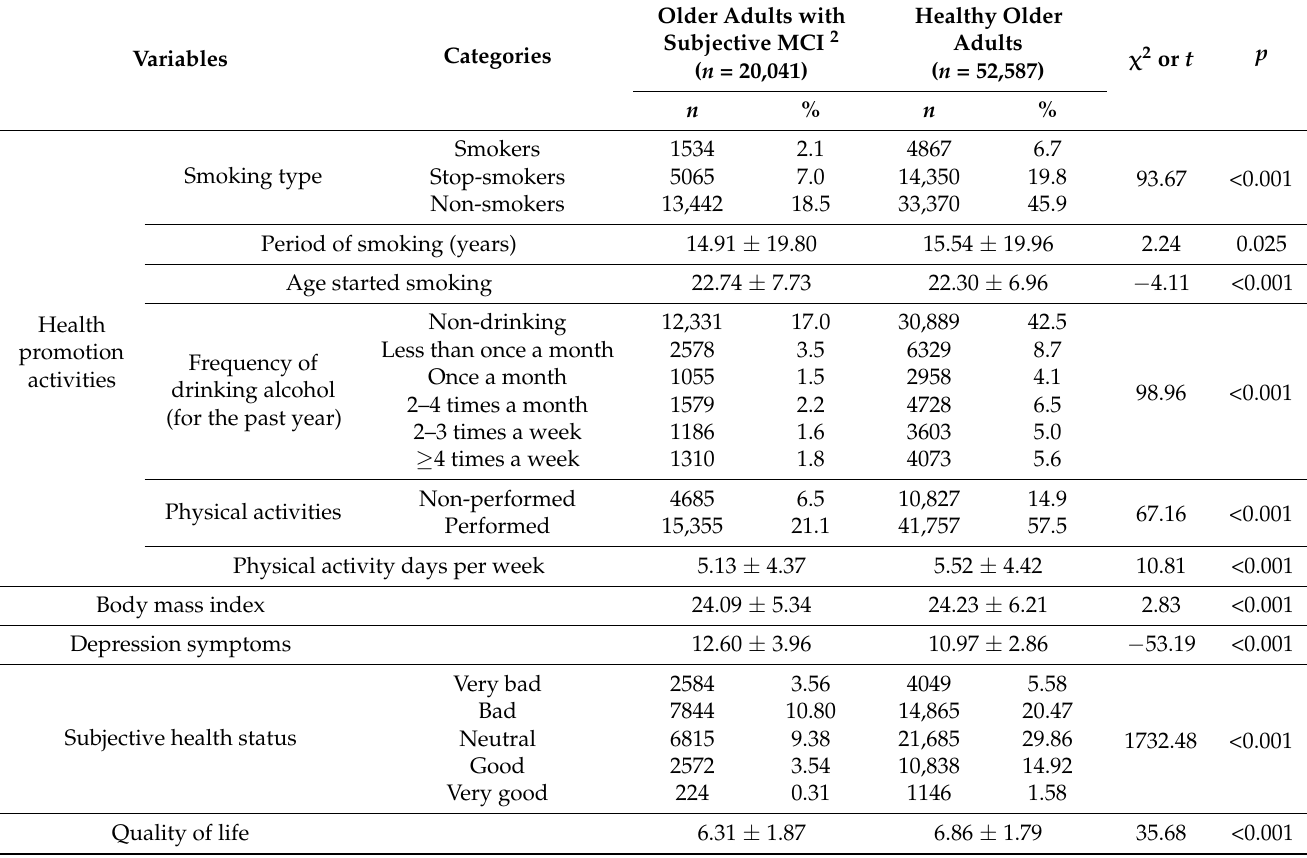
Table 2. Comparison of health promotion activities, BMI, depression symptoms, subjective health